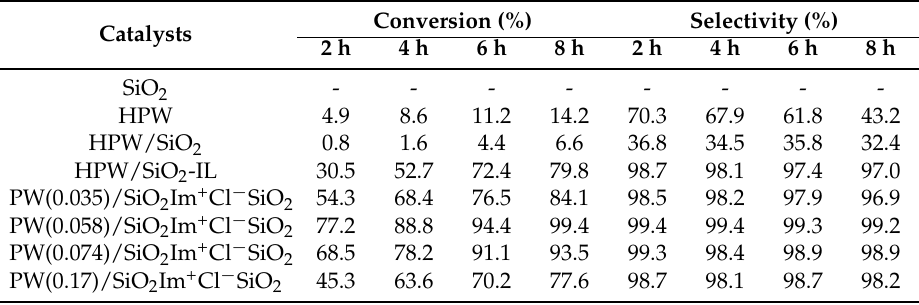
Table 2. Catalytic performances of cyclooctene with various catalysts.